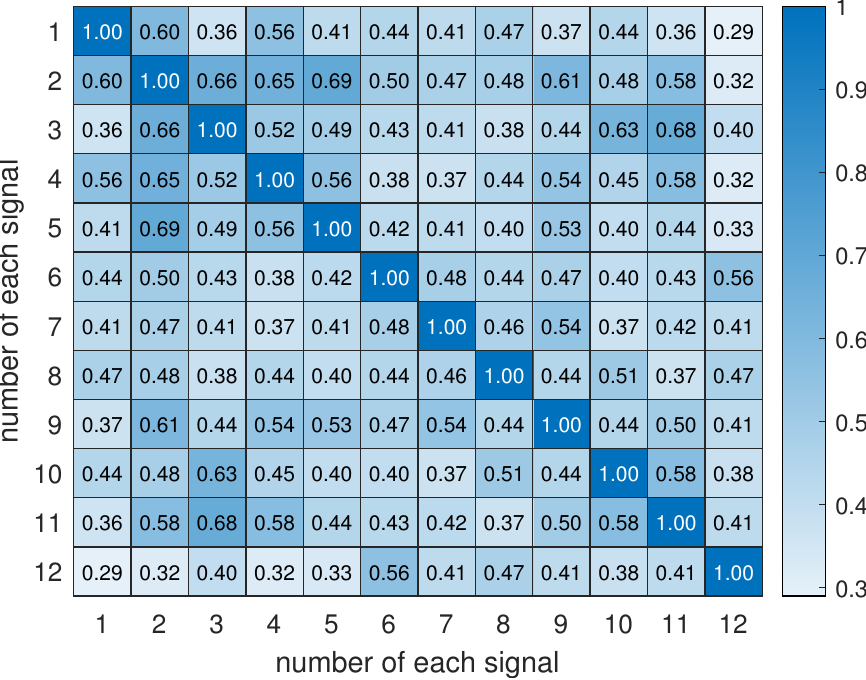
Figure 8. The correlation coefficient matrix of the received 5th group signals after source deconvolu- tion (14.7 km source